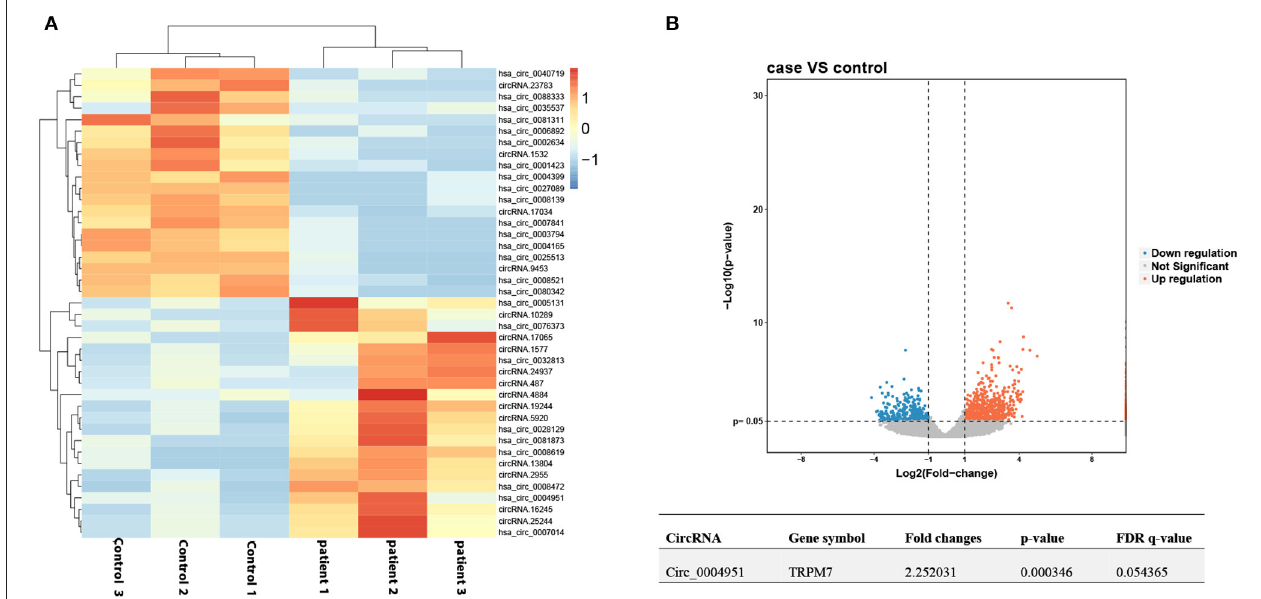
FIGURE 1 | Profile of circ_00004951 expression in kidney tissues of DKD patients. (A) Heat maps and (B) volcano plots.